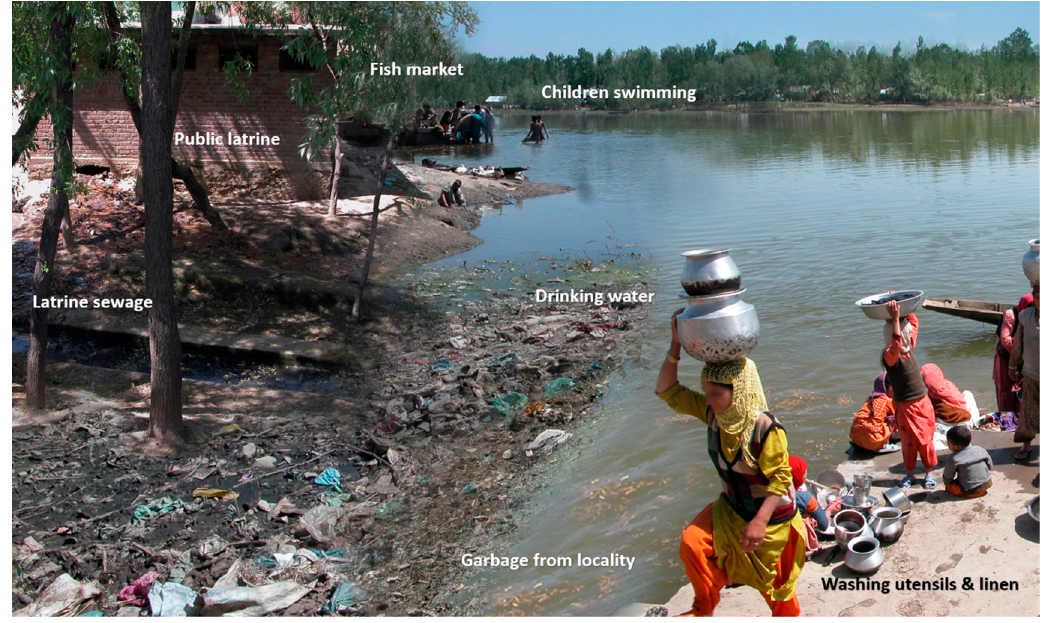
Figure 3. Epidemic region: Kashmir, 1978. Drinking water is collected from a canal in which public latrine sewage flows, garbage of the whole locality is dumped, utensils and linen are washed, children swim, and locals buy fish (Adapted from Khuroo, et al. [4]).